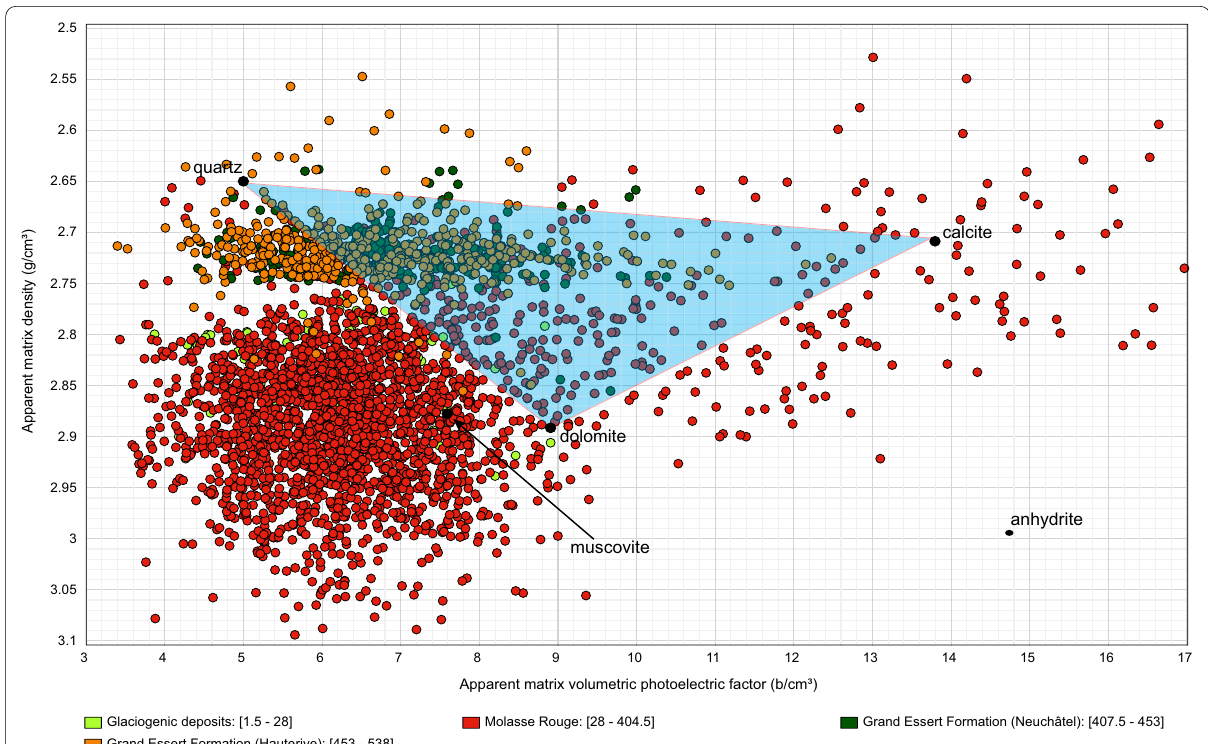
Fig. 11 Matrix density versus volumetric photoelectric factor for the derivation of lithotypes based on well-log calculations from Geo-01’s density logs. Formation depths in meters are stated in square